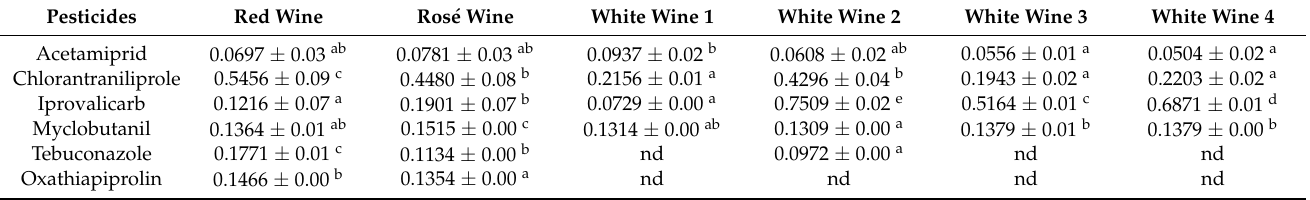
Table 3. The concentrations of the pesticide residues (ng/g) found for the red, rosé, and white wine samples.